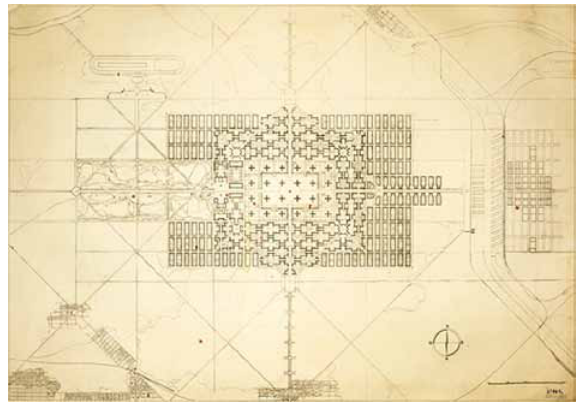
fig. 1. Plan of Contemporary City for Three Million Inhabitants. fig. 2. Perspective views of Contemporary City for Three